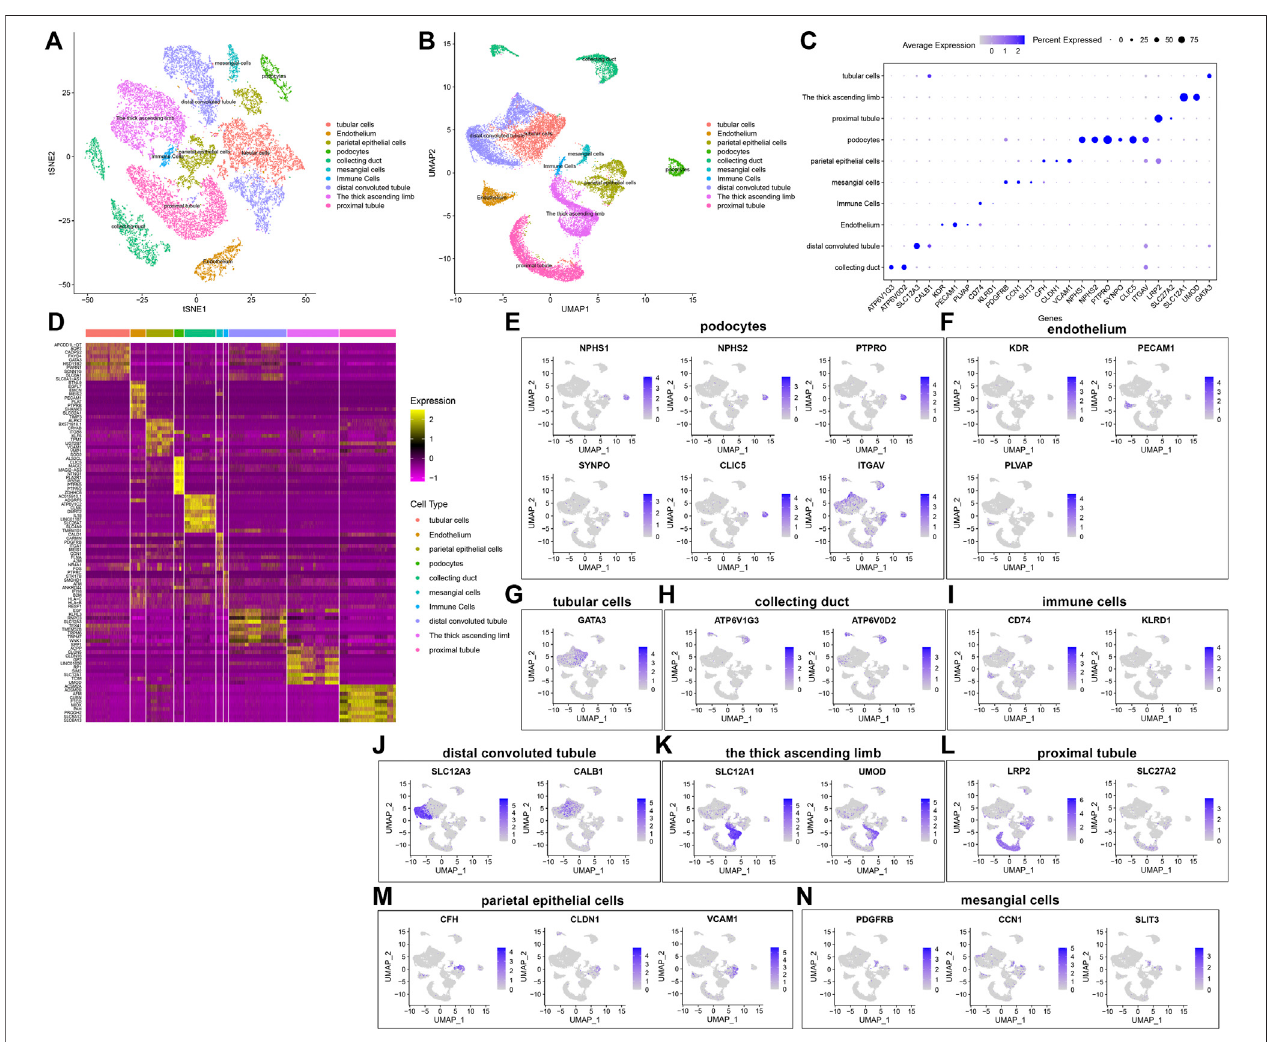
FIGURE 5 | Identi fi cation of cell types and their marker genes. (A,B) Identi fi cation of cell types in the diabetic kidney specimens and controls. Each cell type was marked by a unique color. (C) The expression patterns of marker genes among cell types (D) Heat map for the top ten marker genes in each cell type. The expression distributionofmarkergenesin (E) podocytes, (F) endothelium, (G) tubularcells; (H) collectingduct; (I) immunecells; (J) distalconvoluted tubule; (K) thethickascending limb; (L) proximal tubule; (M) parietal epithelial cells; and (N) mesangial cells.